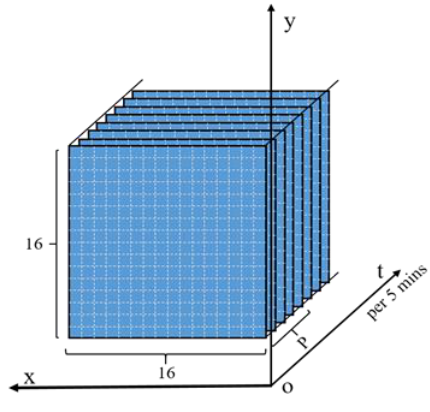
Figure 3. The structure of the neural network.